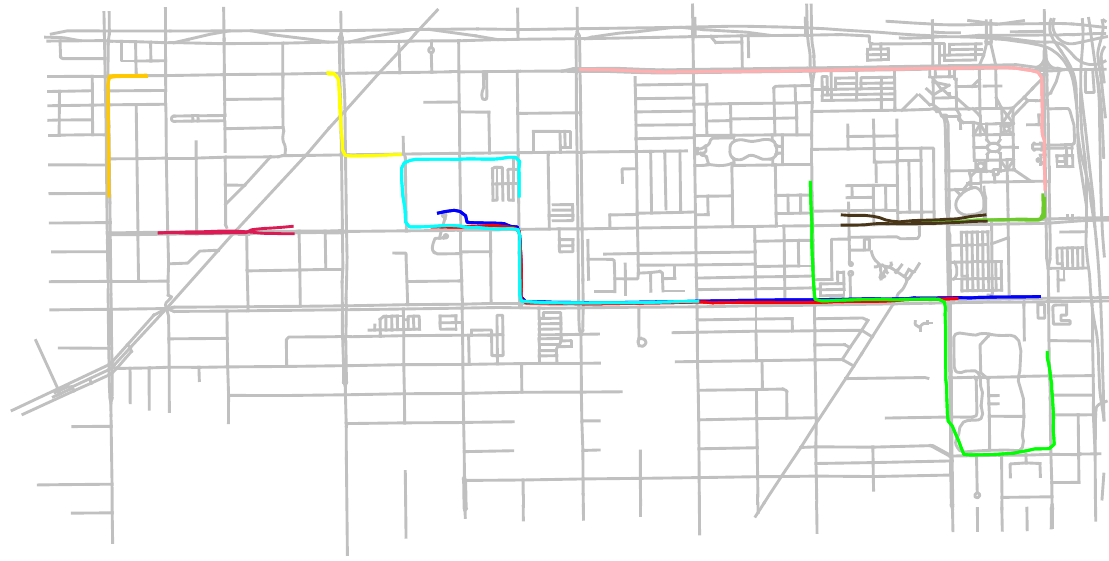
Figure 13. Some of the most interesting movement patterns extracted from the traffic dataset. Each color represents a pattern.